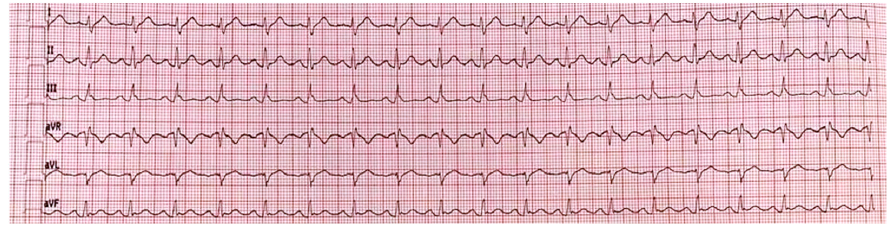
Figure 3. Peripheral-leads ECG showing conversion to regular sinus rhythm with normal ventricular rate.